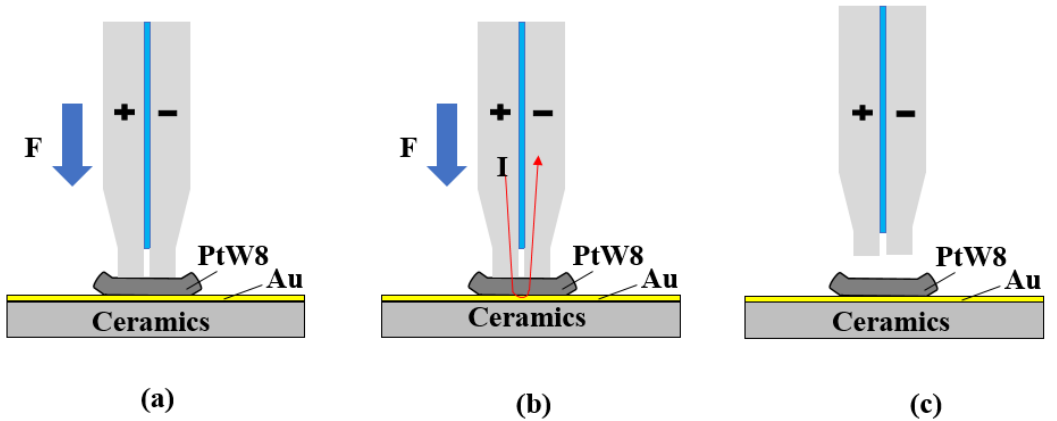
Figure 3. Schematic of the parallel-gap resistance microwelding process: ( a ) preloading stage, ( b ) welding stage, and ( c ) after welding.